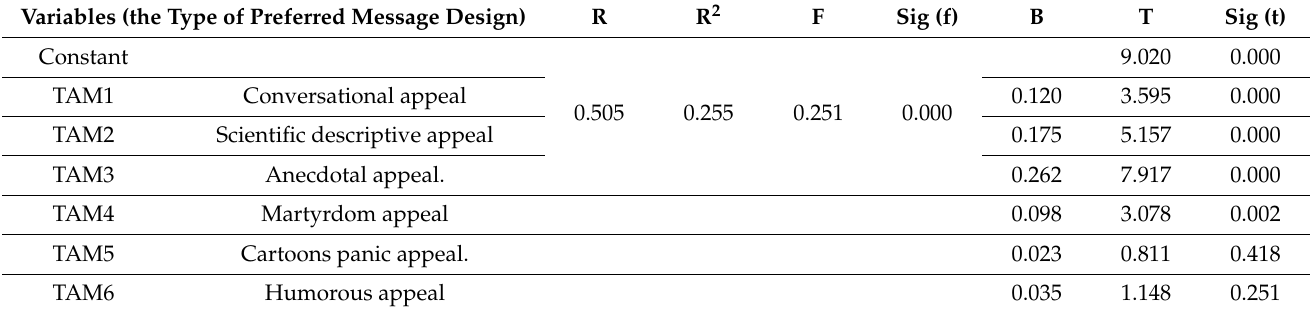
Table 6. Result for the (H1b) hypothesis.